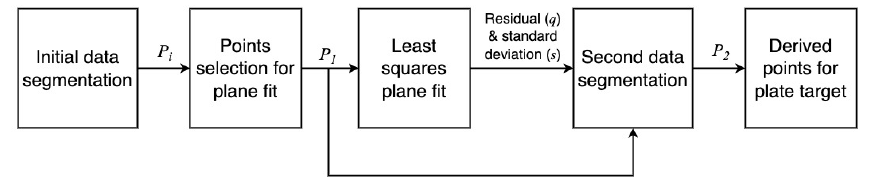
Figure 17. Procedure to calculate plate-derived point